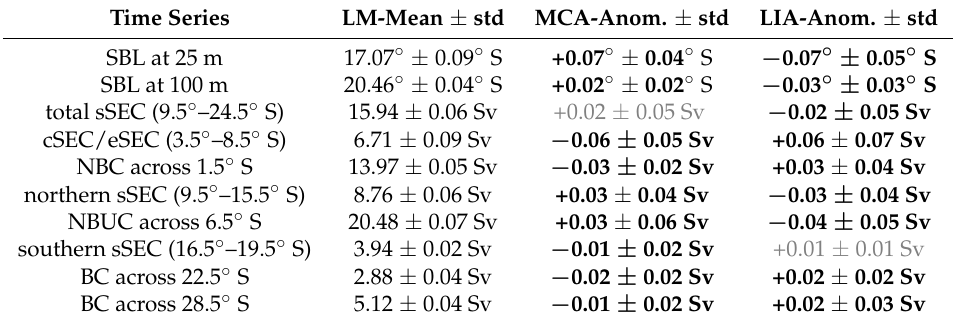
Table 1. LM-mean and standard deviation (std) and MCA/LIA anomalies (MCA-anom., LIA-anom., with respect to the LM-mean) and std (relative to their 300-year intervals) corresponding to the SBL time series in Figure 4a,b and the volume transport time series in Figures 4c and 5a–f. The total sSEC, cSEC/eSEC, northern sSEC, and southern sSEC transports are across 30 ◦ W. Statistically-significant MCA/LIA anomalies are marked in bold, while non-significant ones appear in gray, according to Table 2.